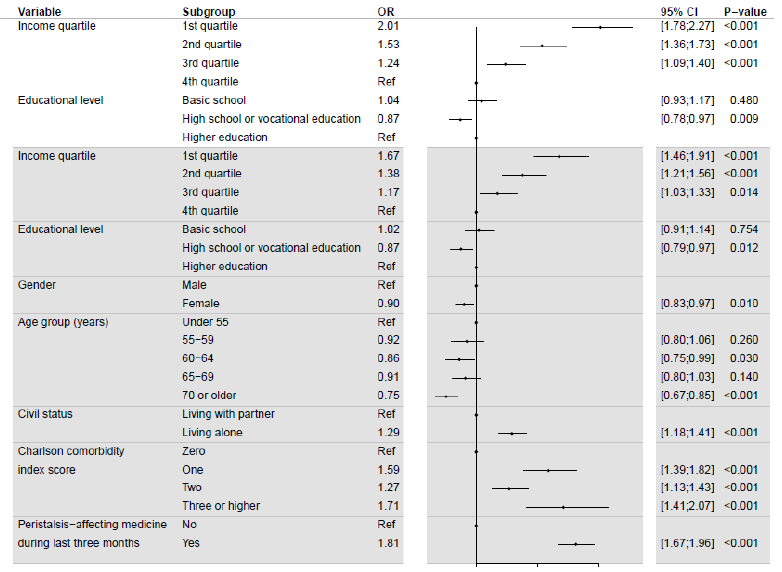
Figure 2. Odds ratios of incomplete colonoscopy due to inadequate bowel preparation from simple (white) and full (grey) logistic regression models.